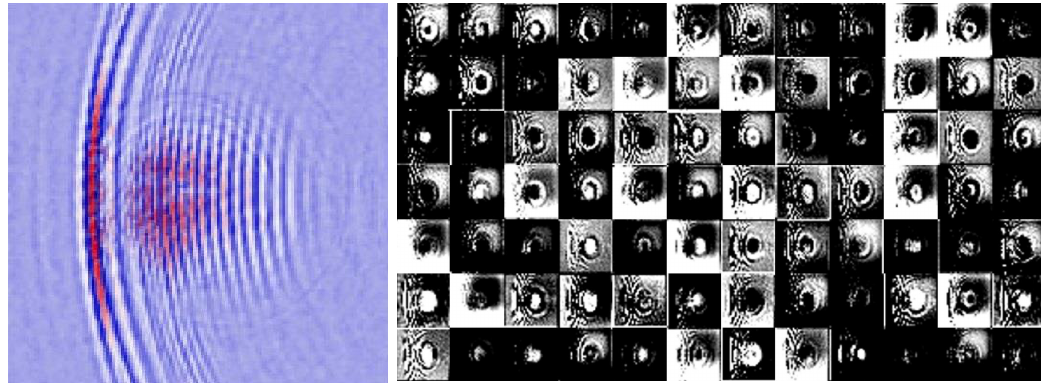
Figure 14. Visualization of USresNet B4 layer activation generated by an ultrasonic image with